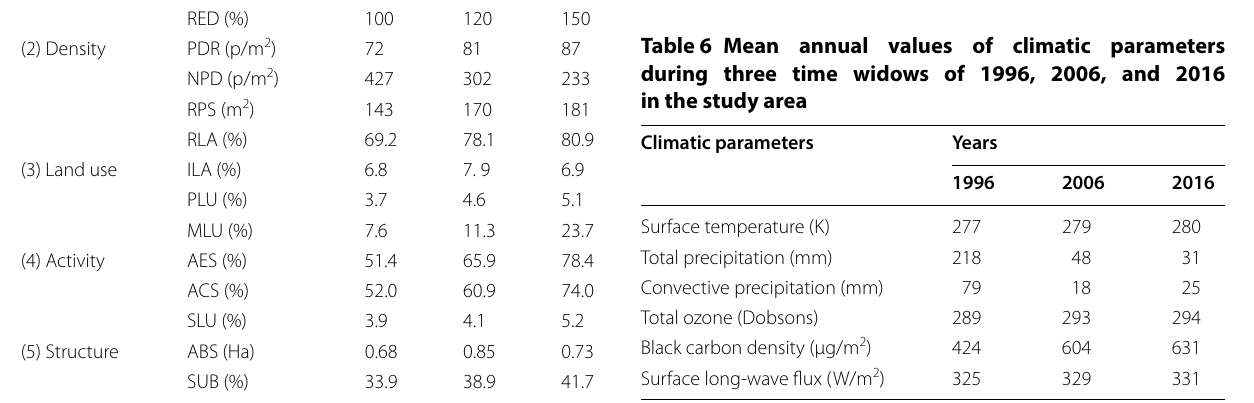
Table 6 Mean annual values of climatic